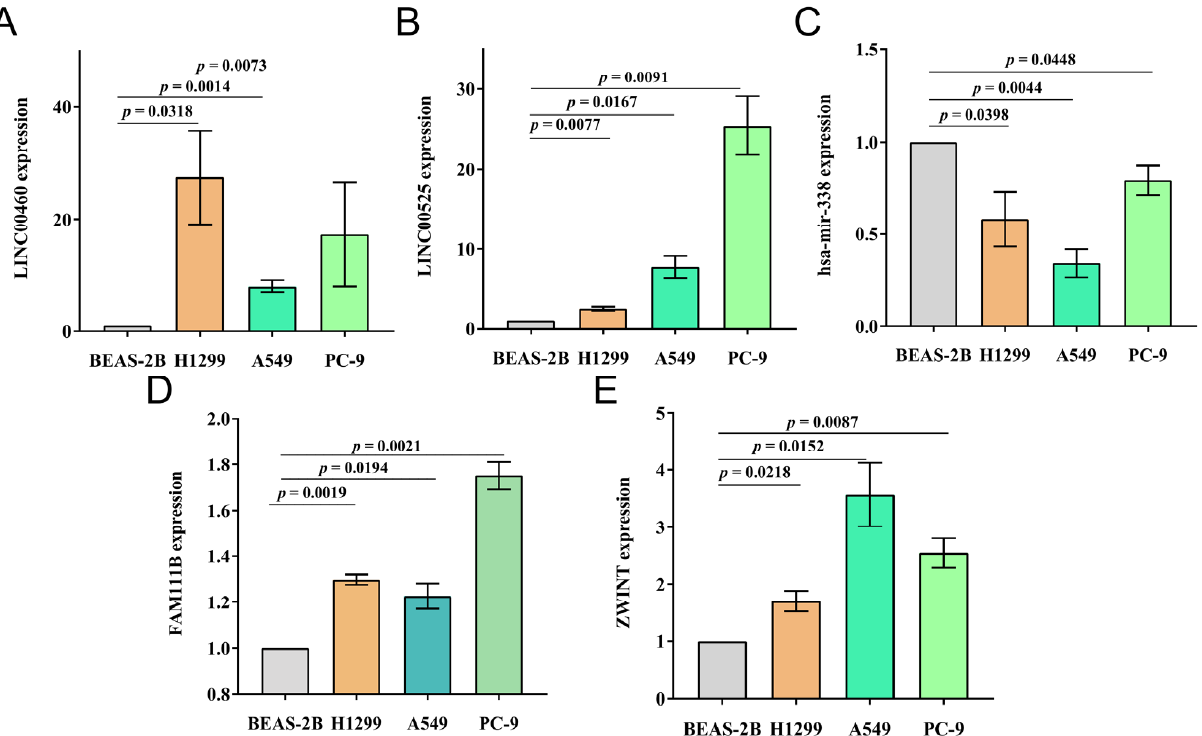
Figure 6. In vitro verification of prognosis model in cell lines by RT-qPCR. ( A – E ) The expression of ( A ) LINC00460, ( B ) LINC00525, ( C ) has-mir-338, ( D ) FAM111B and ( E ) ZWINT in normal lung epi ‐ thelial cell lines (BEAS ‐ 2B) and three LUAD cell lines (H1299, A549 and PC ‐ 9).